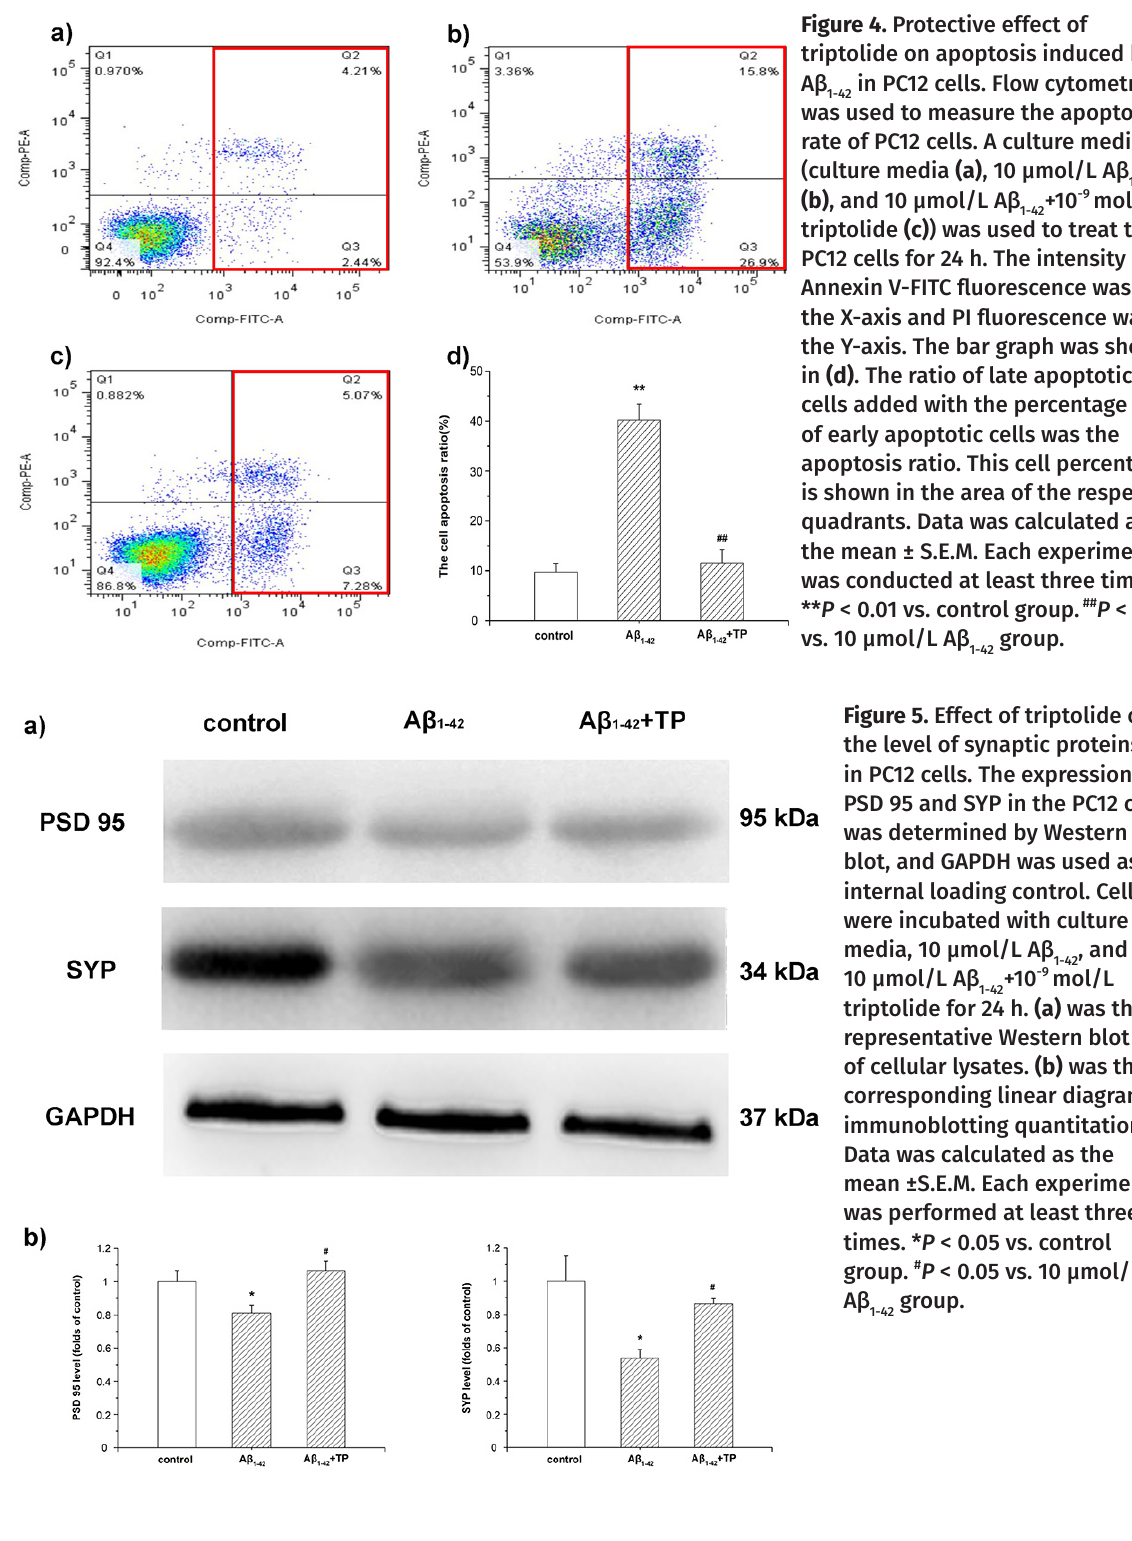
Figure 4. Protective effect of triptolide on apoptosis induced by Aβ in PC12 cells. Flow cytometry 1-42 was used to measure the apoptotic rate of PC12 cells. A culture media (culture media (a) , 10 μmol/L Aβ 1-42 (b) , and 10 μmol/L Aβ +10 -9 mol/L 1-42 triptolide (c) ) was used to treat the PC12 cells for 24 h. The intensity of Annexin V-FITC fluorescence was on the X-axis and PI fluorescence was on the Y-axis. The bar graph was shown in (d) . The ratio of late apoptotic cells added with the percentage of early apoptotic cells was the apoptosis ratio. This cell percentage is shown in the area of the respective quadrants. Data was calculated as the mean ± S.E.M. Each experiment was conducted at least three times. ** P < 0.01 vs. control group. ## P < 0.01 vs. 10 μmol/L Aβ group. 1-42 Figure 5. Effect of triptolide on the level of synaptic proteins in PC12 cells. The expression of PSD 95 and SYP in the PC12 cells was determined by Western blot, and GAPDH was used as an internal loading control. Cells were incubated with culture media, 10 μmol/L Aβ , and 1-42 10 μmol/L Aβ +10 -9 mol/L 1-42 triptolide for 24 h. (a) was the representative Western blot of cellular lysates. (b) was the corresponding linear diagram of immunoblotting quantitation. Data was calculated as the mean ±S.E.M. Each experiment was performed at least three times. * P < 0.05 vs. control group. # P < 0.05 vs. 10 μmol/L Aβ 1-42